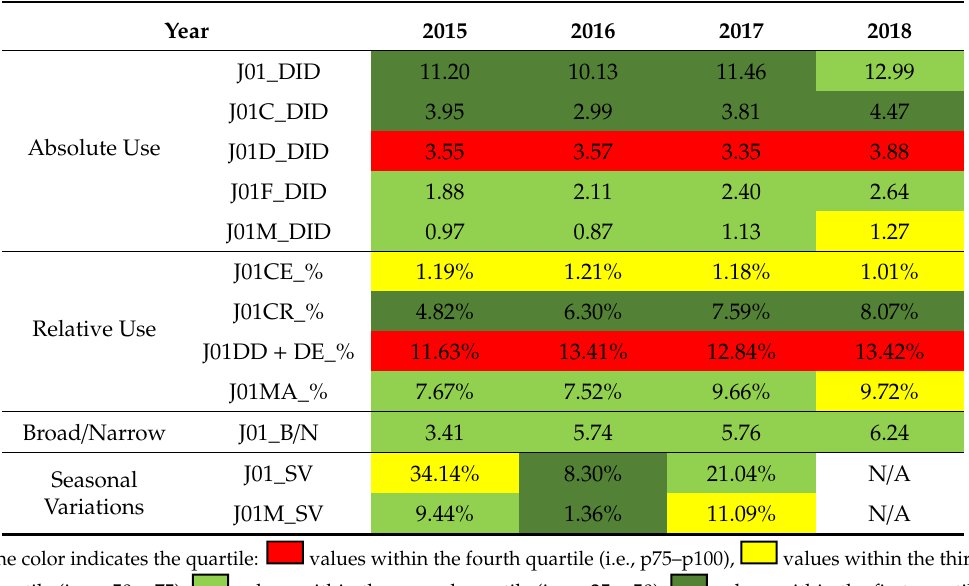
Table 2. Quality indicators for antibiotic use in Shaanxi Province in comparison with 31 European countries, 2015–2018.